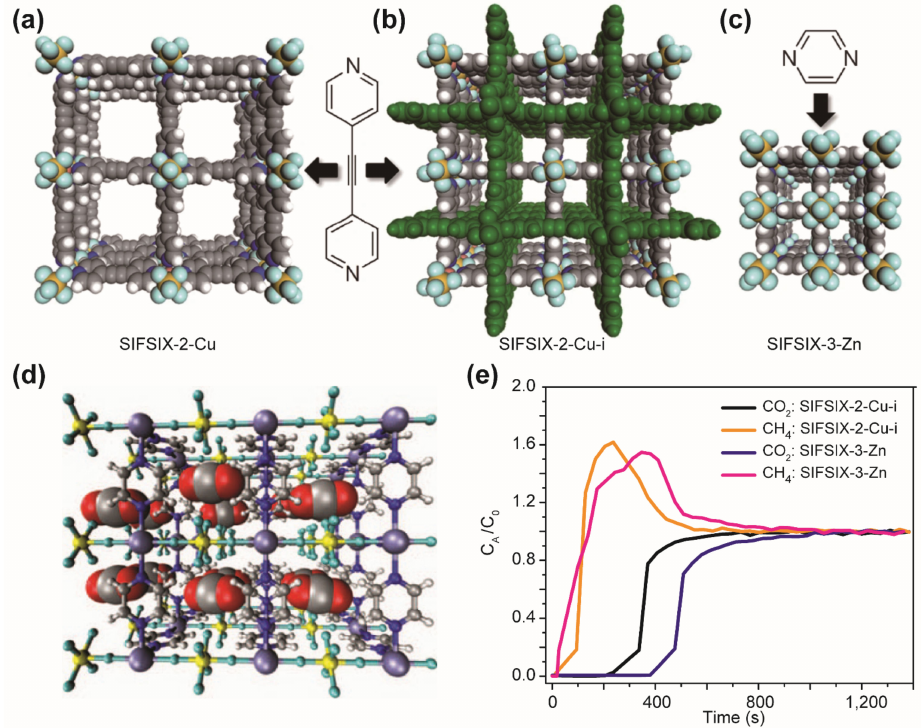
Figure 5. ( a – c ) Schematic diagram of the frameworks of SIFSIX-2-Cu ( a ), SIFSIX-2-Cu-i ( b ) and SIFSIX-3-Zn ( c ). Color code: Si (yellow), C (gray), F (light blue), N (blue), H (white). For clarity, the green structure indicates the interpenetrated network. ( d ) Structure diagram of interactions between the CO 2 molecules and SiF 62 − . Color code: C (gray), F (green), N (blue), Si (yellow), O (red), H (white), Zn (purple). ( e ) Breakthrough curves for a CO 2 /CH 4 (50/50) mixture for SIFSIX-2-Cu-i and SIFSIX-3-Zn at 298K, 1atm. Reproduced with permission from Nugent et al., Nature; published by Springer Nature, 2013